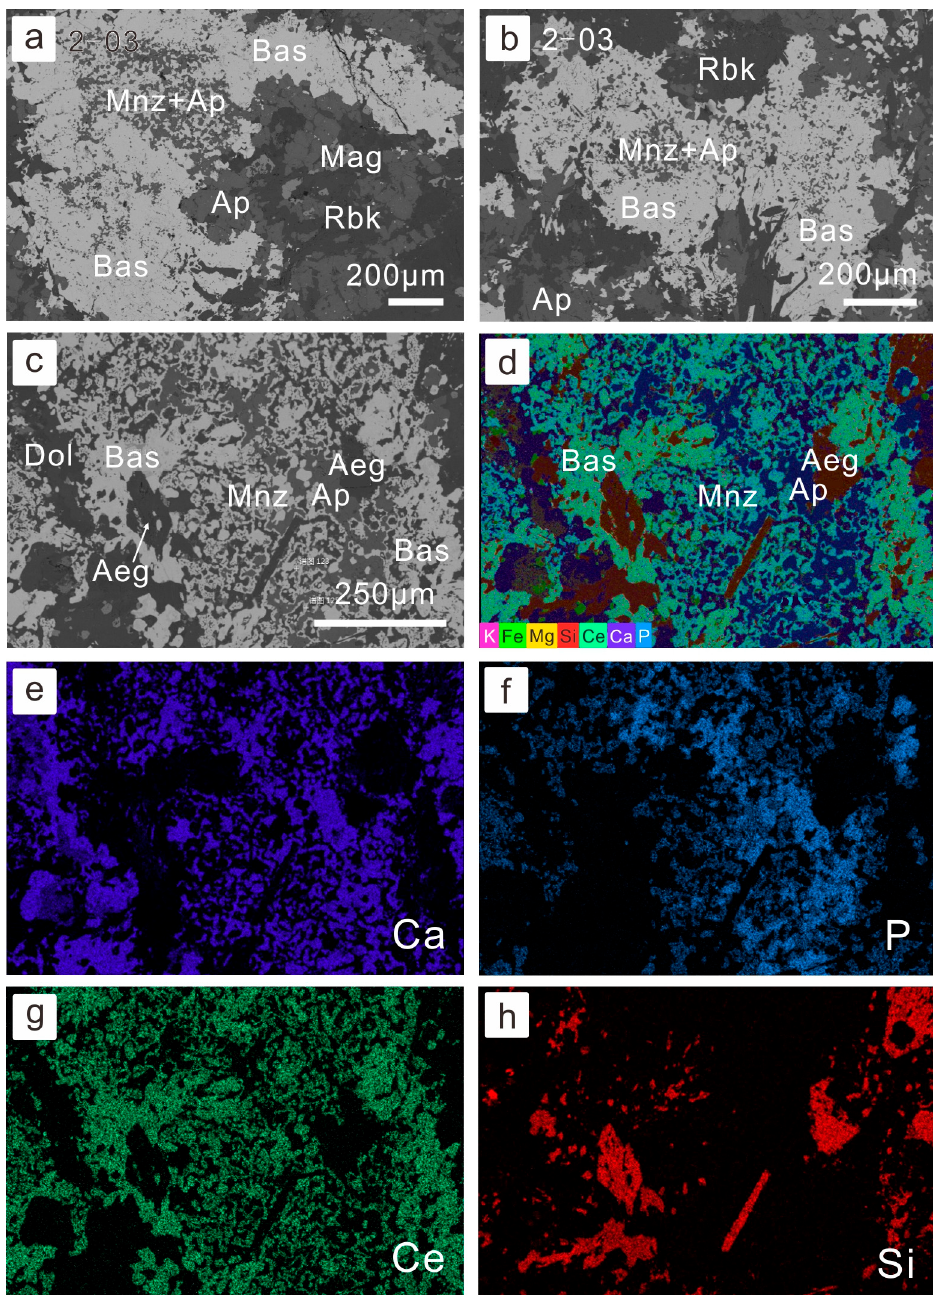
Figure 3. Petrography of replacement of bastnaesite by monazite: ( a , b ) monazite associated with apatite and replaced by bastnasite–apatite association (BSE image for sample 14BY-2-03, sodium-amphibole-rich ore); ( c ) coarser-grain bastnaesite replaced and associated with monazite and apatite (BSE image for sample BY-4, fluorite-rich REE-Nb ore); ( d ) compiled multi-element x-ray mapping, where monazite displays as light blue and bastnaesite has a green color; ( e – h ) single-element x-ray mapping of ( c ). Abbreviation of minerals: Dol—dolomite; Mnz—monazite; Bas—bastnaesite; Mag—magnetite; Rbk—riebeckite; Ap—apatite; Aeg—aegirine.